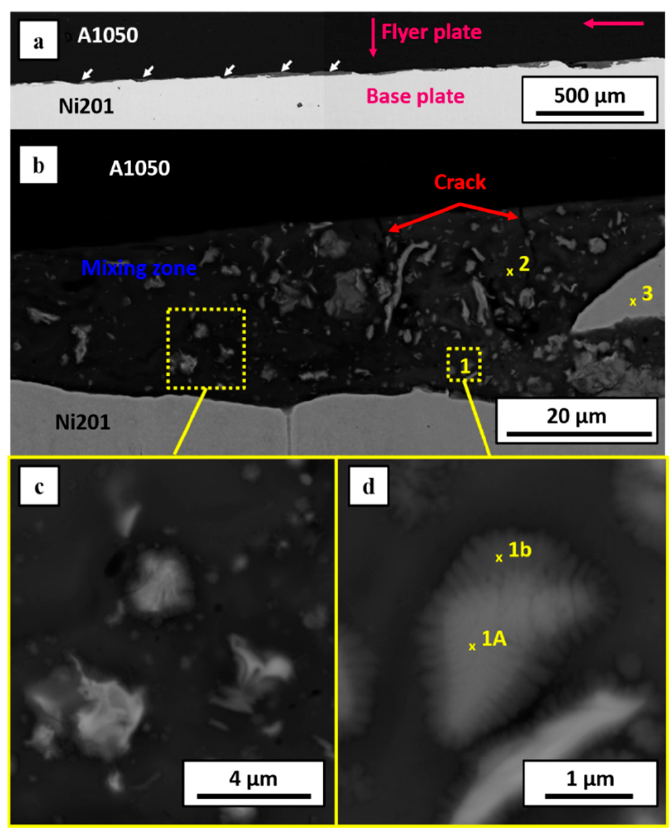
Figure 3. Microstructures of explosively welded A1050/Ni201 clad manufactured at V d = 2000 m/s: overall view of wavy interface ( a ), representative part of the melted region of individual wave with its microstructure imaged by backscattered electrons contrast in SEM ( b ) together with the magnification of the microstructure details ( c , d ). Results of chemical analysis marked with points: 1A, 1b, 2 and 3 are collected in Table 3. Table 3. The chemical compositions obtained by SEM/EDS point analysis located in the regions marked with numbers 1–3 in Figure